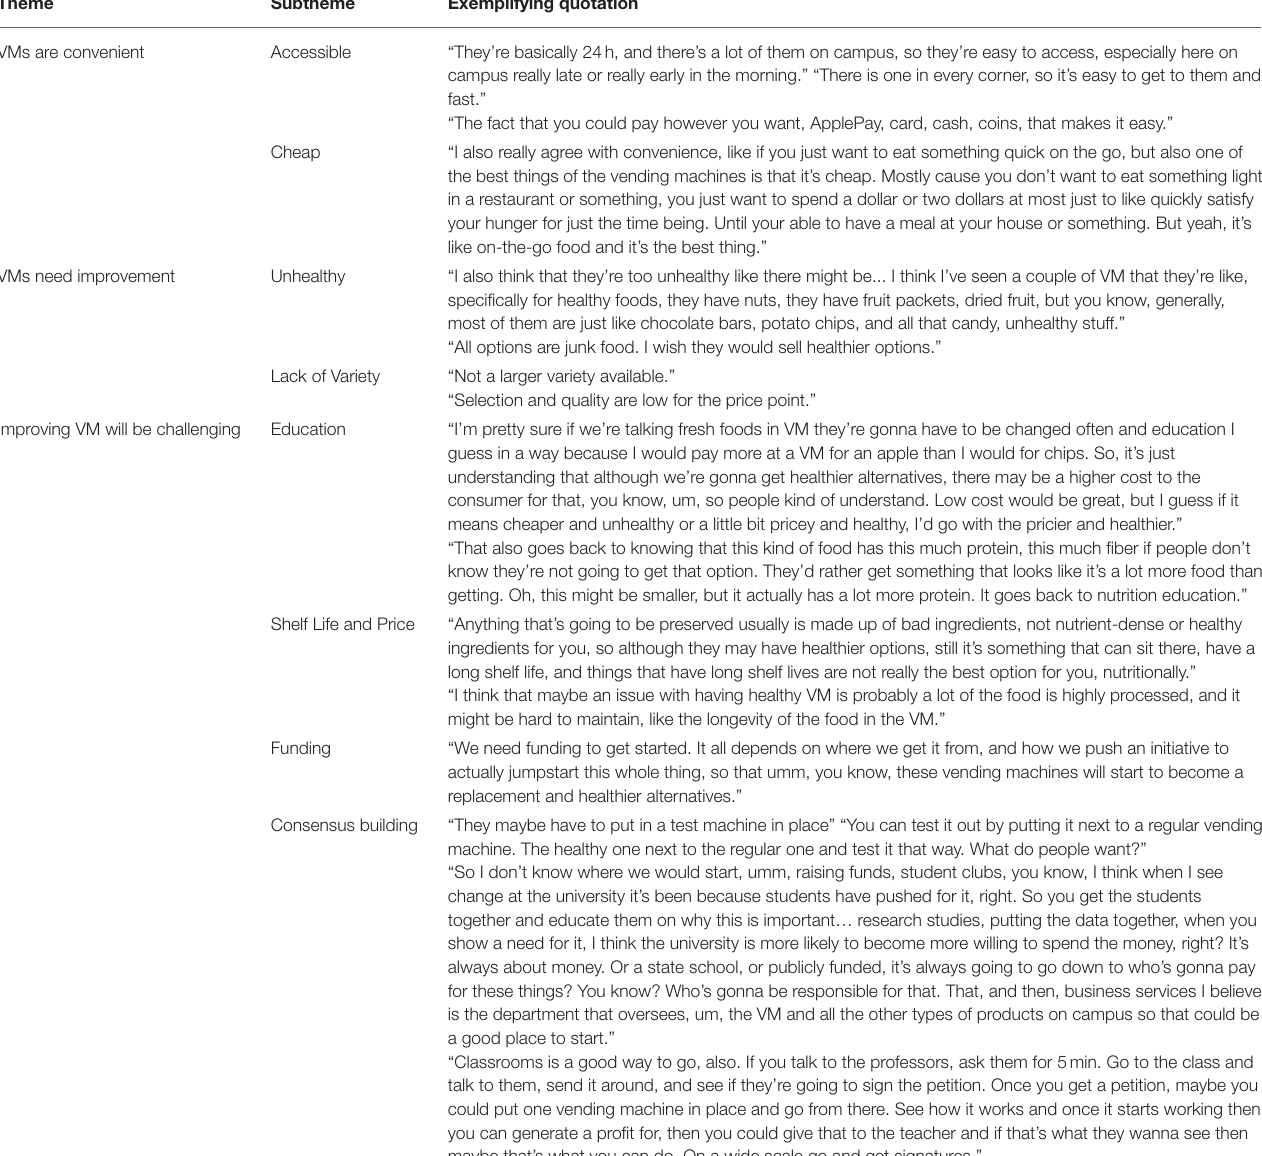
TABLE 3 | Selected quotes illustrating themes and subthemes.